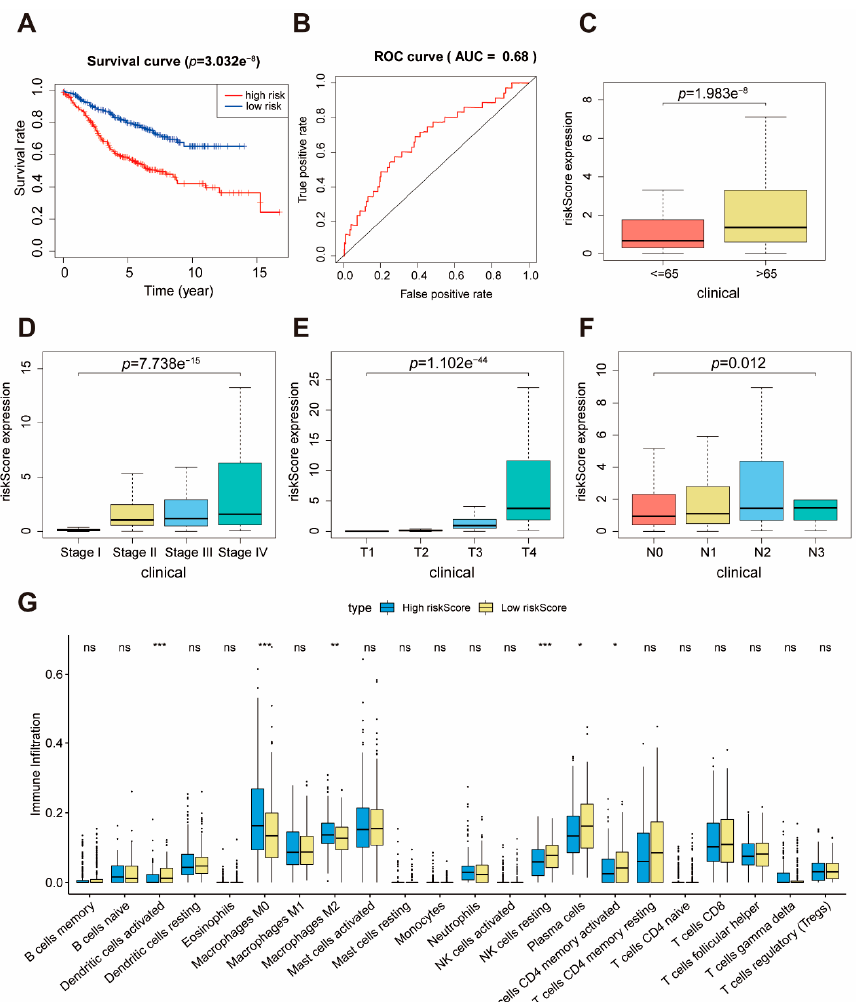
Figure 6. Validation of the prognostic performance of m6A risk score in GSE39582. ( A ) The survival curves of the m6A risk score in GSE39582. Grouping was based on the median m6A risk score in the training set. Red is the high-level group, and blue is the low-level group. ( B ) ROC curve of the m6A risk score forecast result after 1 year. ( C – F ) The relationship between m6A risk score and clinical features of patients. ( G ) Estimated immune cell expression in high and low m6A risk score groups.